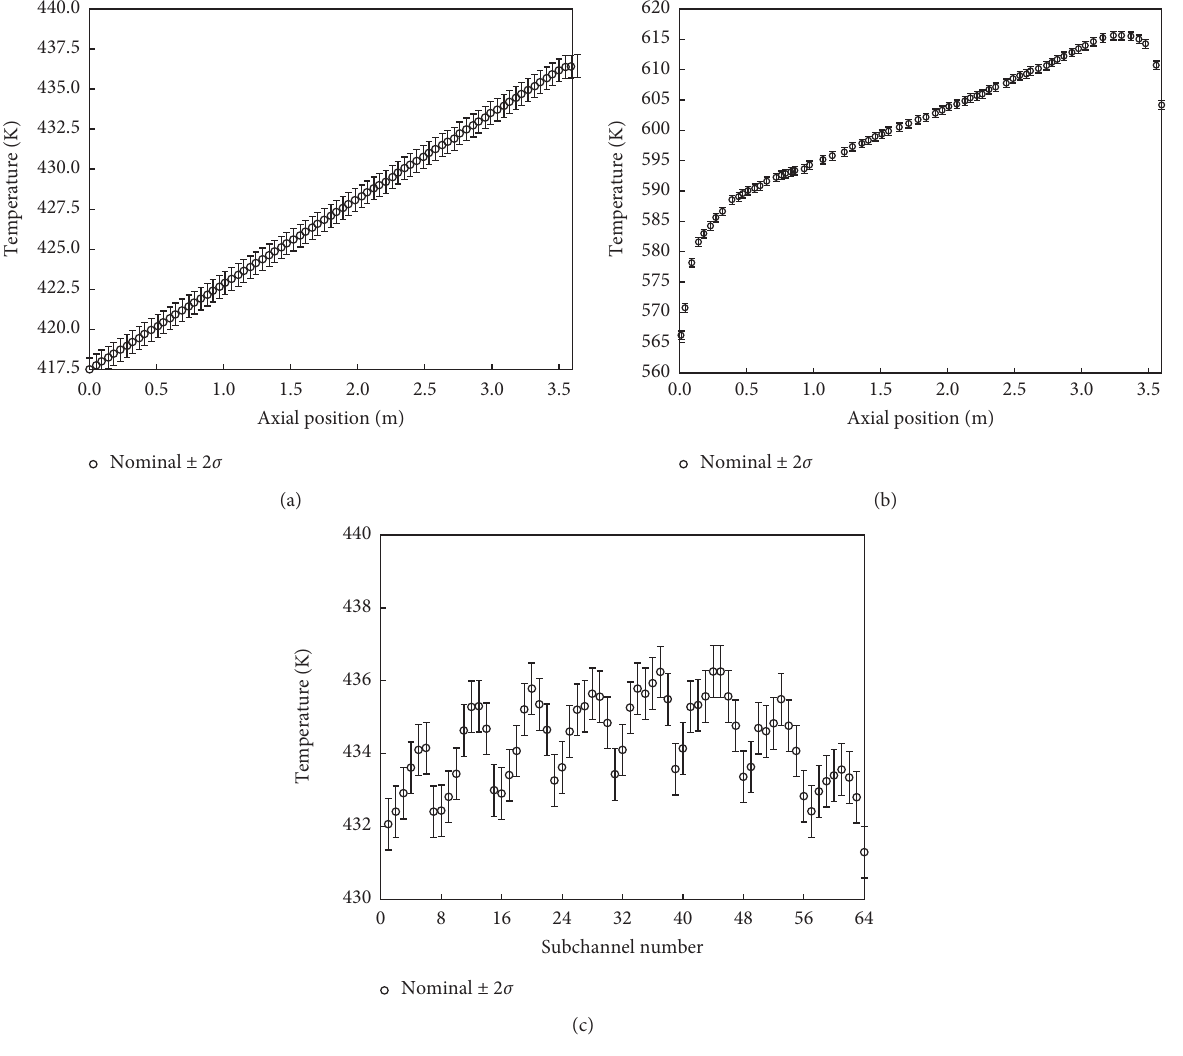
Figure 15: CTF/DAKOTA results for the TMI-1 PWR test case. (a) Axial fluid temperature distribution. (b) Axial surface cladding temperature distribution. (c) Exit fluid temperature